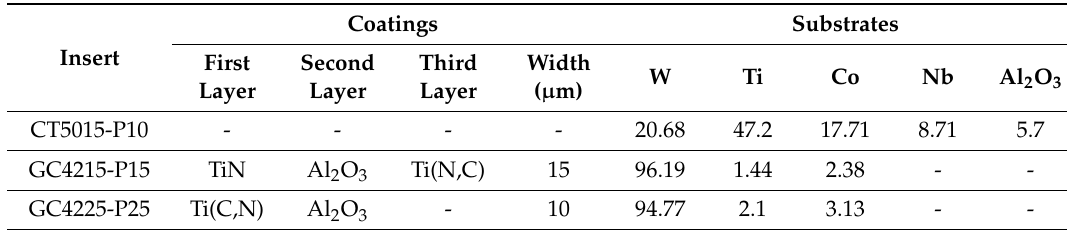
Table 2. Characteristics of inserts.